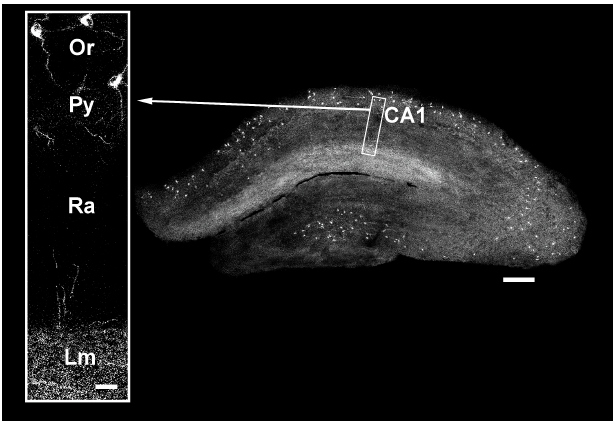
Figure 4. Hippocampal somatostatinergic interneurons. A tissue slice of mouse hippocampus was processed for immunocytochemistry with monoclonal antibody directed against somatostatin and observed with confocal microscopy. The low magnification image is a reconstruction of seven confocal optical images. Note that SRIF-immunoreactive cell bodies (white dots) occur throughout the hippocampal formation. Inset : High magnification image of the CA1 subfield. Somata of SRIF-positive neurons can be detected in the s.o. (Or) but not in the s.p. (Py), whereas immunolabelled fibers are found in the s.r. (Ra) with terminal arborizations in the s.l.m. (Lm). Extensive somatostatin labeling is localized to the Lm, which therefore represents the release site. Scale bars: 200 µm for the low magnification image; 20 µm for the inset image. Modified from [99].